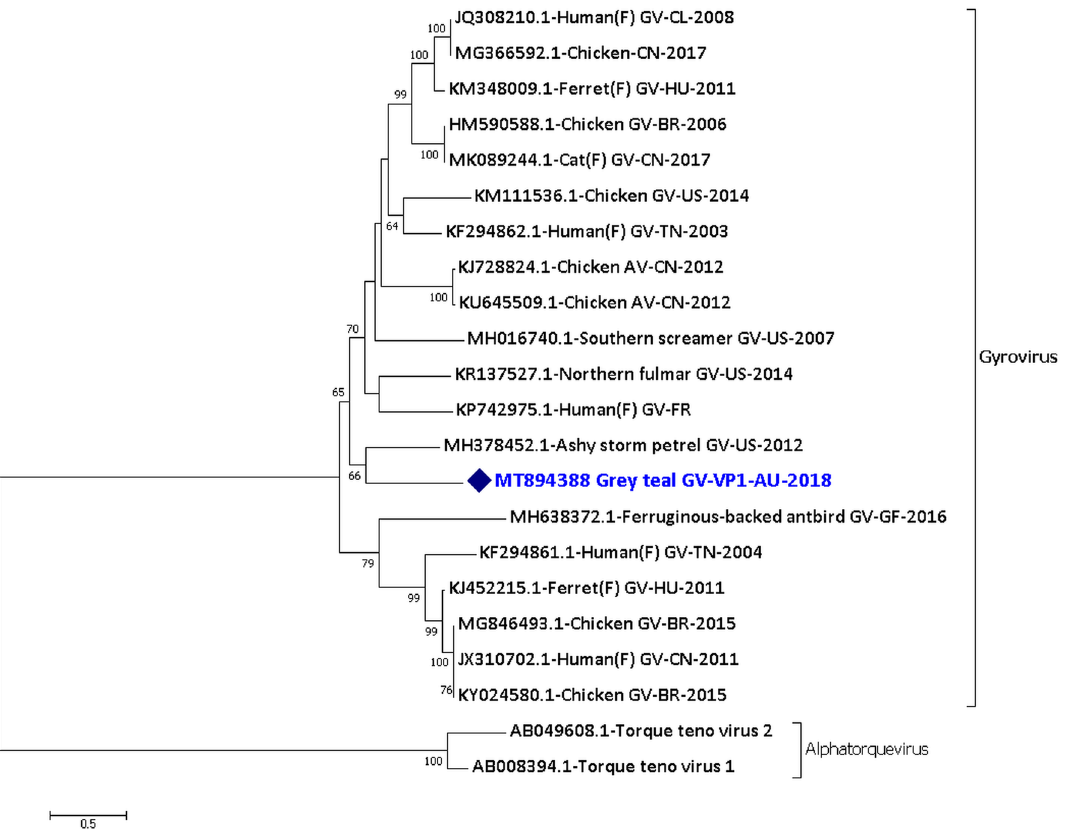
Figure 2. Phylogenetic analysis of the amino acid sequences of the VP1 protein of Grey teal gyrovirus (GTGV/ GT11.18). The amino acid sequences were aligned and analysed using the maximum likelihood method based on the WAG + G + I + F model 73 in MEGACC 74 with a bootstrapping of 1000 replicates. The analysis involved 22 amino acid sequences and all positions containing gaps and missing data were eliminated. The final dataset contained a total of 233 amino acid positions. The numbers at the nodes represent bootstrap values and only bootstrap values at or above 60% are shown. Grey teal gyrovirus is shown in blue and marked with a blue diamond. (F) shows faecal